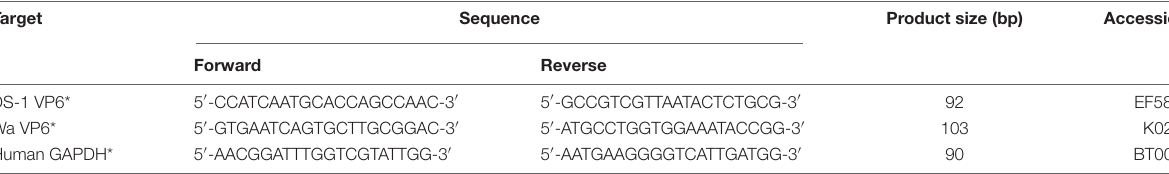
TABLE 1 | Primer sequences used in this study.